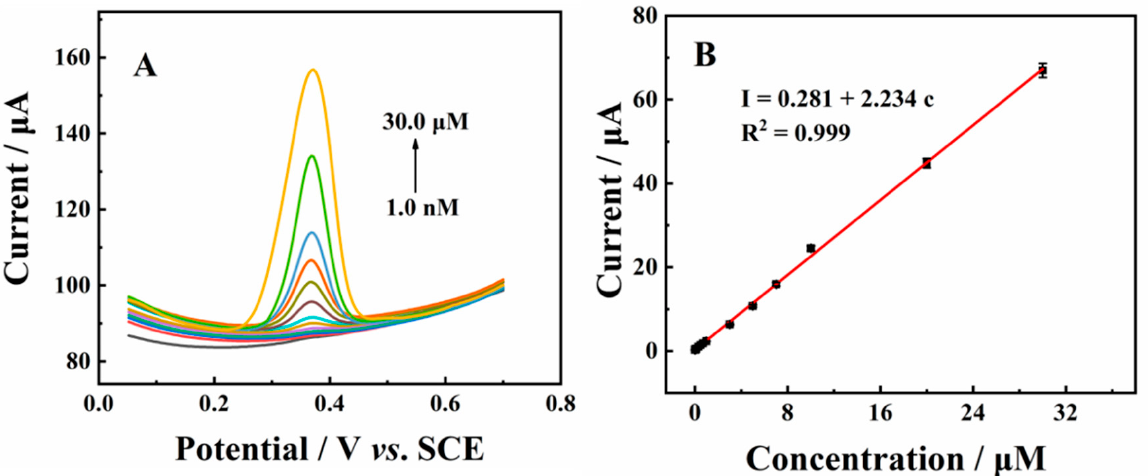
Figure 7. ( A ) DPV curves of N-SC/ β -CD-MOFs/GCE in 0.1 M PBS (pH 7.0) with different concentra- tions of AC (1.0 nM, 5.0 nM, 10.0 nM, 50.0 nM, 100.0 nM, 500.0 nM, 1.0 μ M, 3.0 μ M, 5.0 μ M, 7.0 μ M, 10.0 μ M, 20.0 μ M and 30.0 μ M). ( B ) The linear relationship between peak current and concentration of AC.